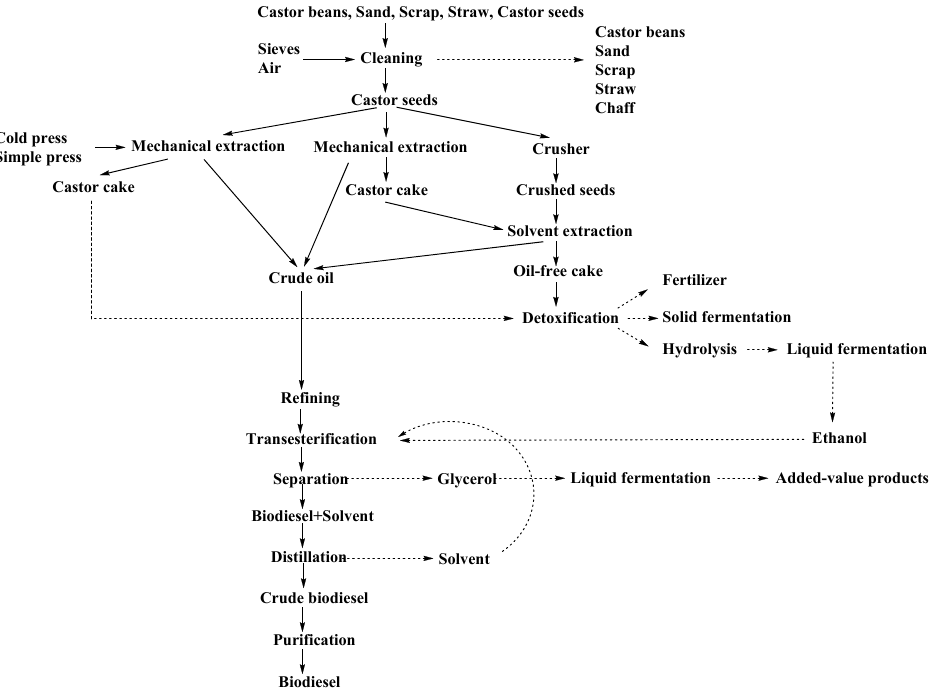
Figure 2. General scheme to produce biodiesel from castor oil (adapted from [40,46]).